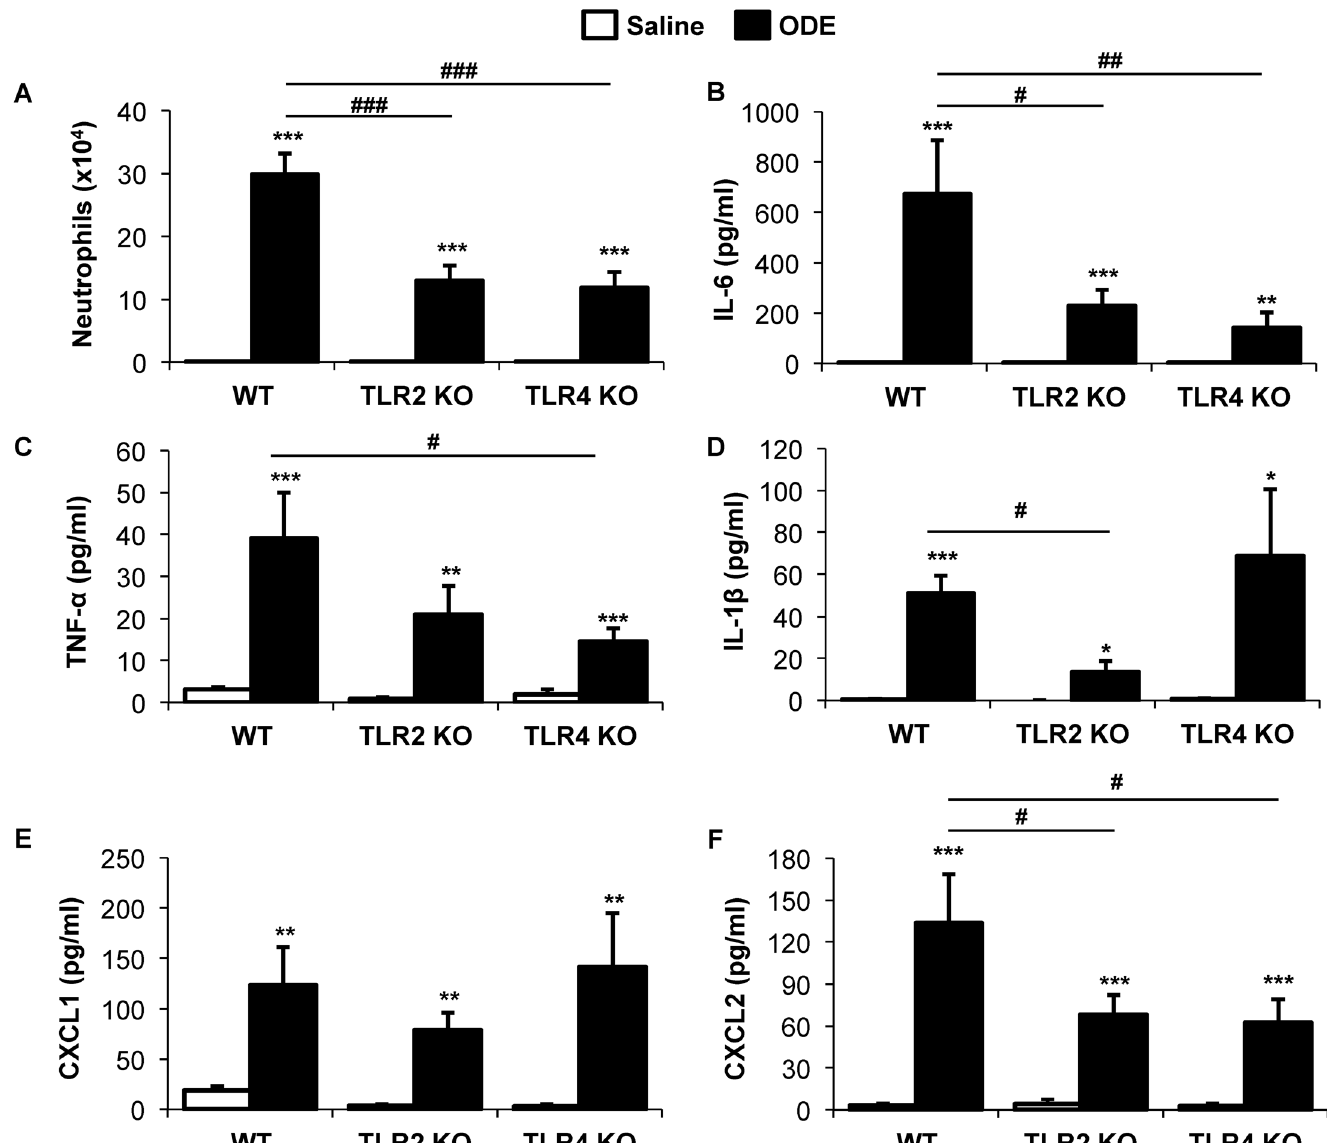
Fig 2. Repetitive inhalant organic dust extract (ODE)-induced airway inflammatory responses were reduced in TLR2 and TLR4 KO mice. WT, TLR2 KO, and TLR4 KO mice were i . n . treated with ODE daily or saline for 3 weeks whereupon animals were euthanized 5 hrs following final exposure. Neutrophil recruitment ( A ), IL-6 ( B ), TNF- α ( C ), IL-1 β ( D ), CXCL1 ( E ), and CXCL2 ( F ) were determined in bronchoalveolar lavage fluid. Bar graphs represent the mean with standard error bars shown (N = minimum of 6 mice/group from 3 independent studies). Statistical significance denoted by asterisks ( * p < 0.01, ** p < 0.01, *** p < 0.001) as compared to respective saline treatment group. Line denotes statistical significance (#p < 0.05, ##p < 0.01, ###p < 0.001) of WT vs. TLR2 and TLR4 KO mice.